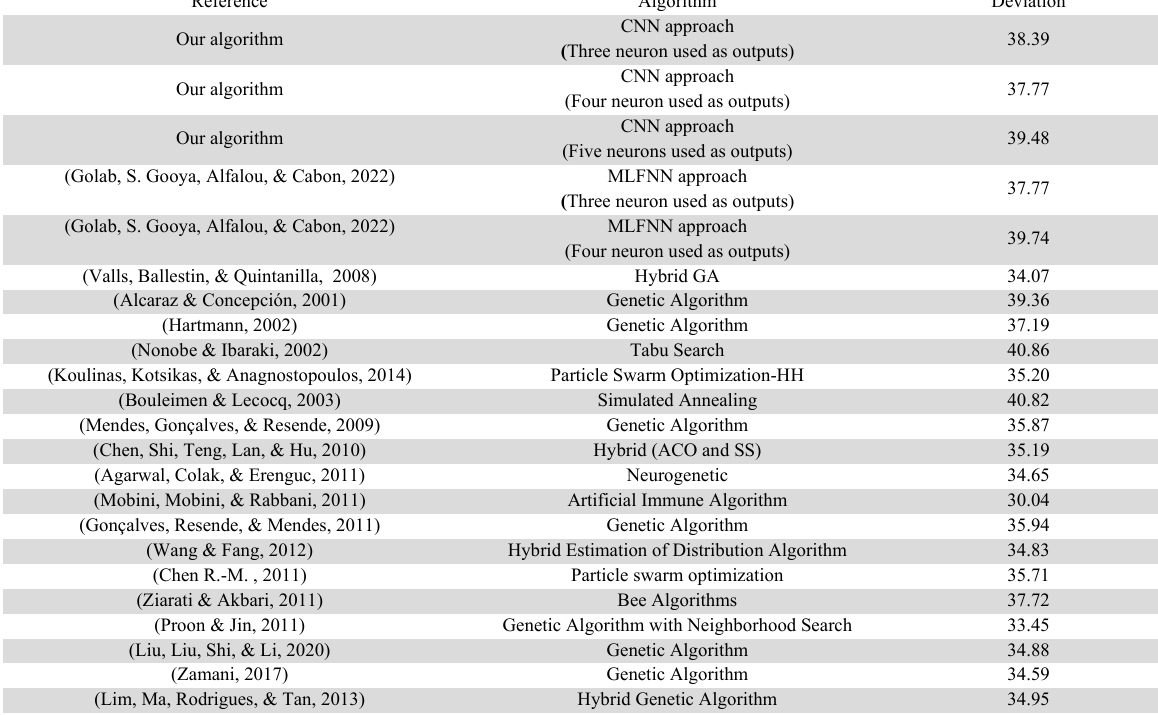
The percentage of average deviations from critical path lower bound for the J120 obtained by our algorithm shows that they are not the best, but sufficiently competitive.